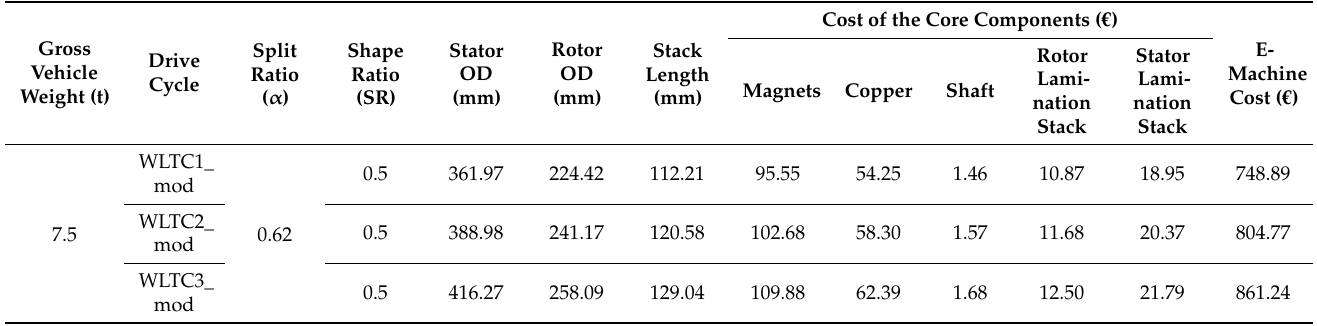
Figure 6. Cost ‐ efficient e ‐ machine geometry and costs for a 7.5 t vehicle. Figure 6. Cost-efficient e-machine geometry and costs for a 7.5 t vehicle. Table 9. Overview of the most cost-effective e-machines for different use cases in the 7.5 t vehicle category.